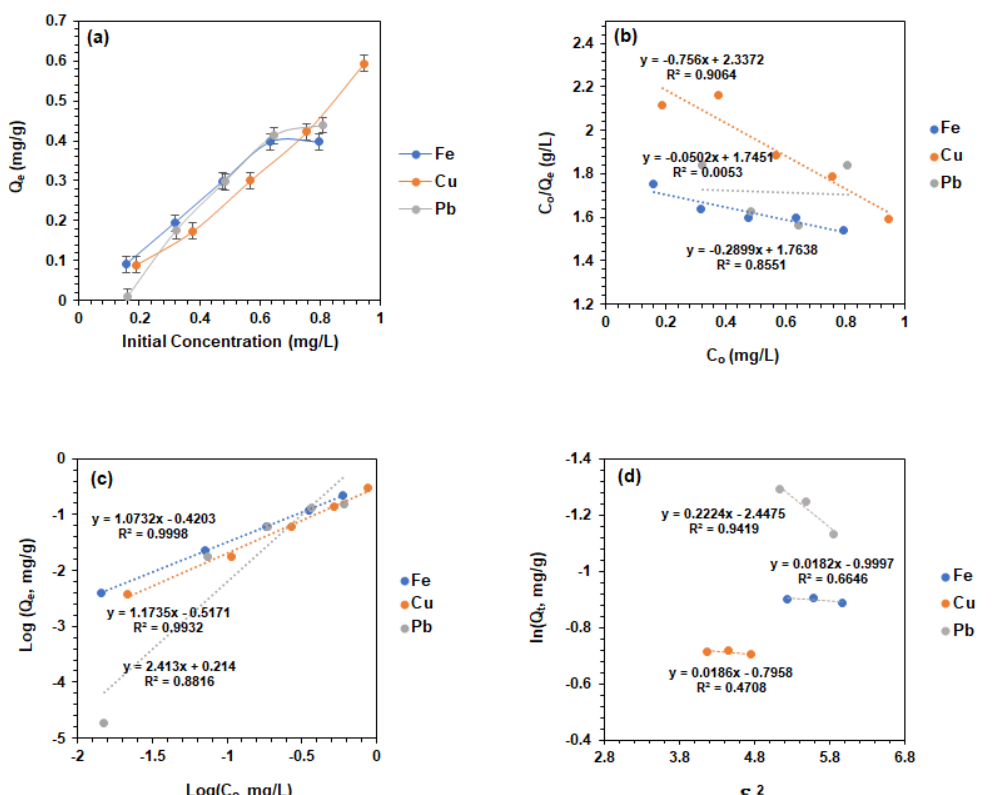
Figure 3. ( a ) Effect of metal ion initial concentration on the adsorption capacity of MXM ; ( b ) Langmuir isotherm model for the adsorption of iron(II), Cu(II), and lead(II) ions by MXM ; ( c ) Freundlich isotherm model for the adsorption of iron(II), Cu(II), and lead(II) ions by MXM ; ( d ) DKR isotherm